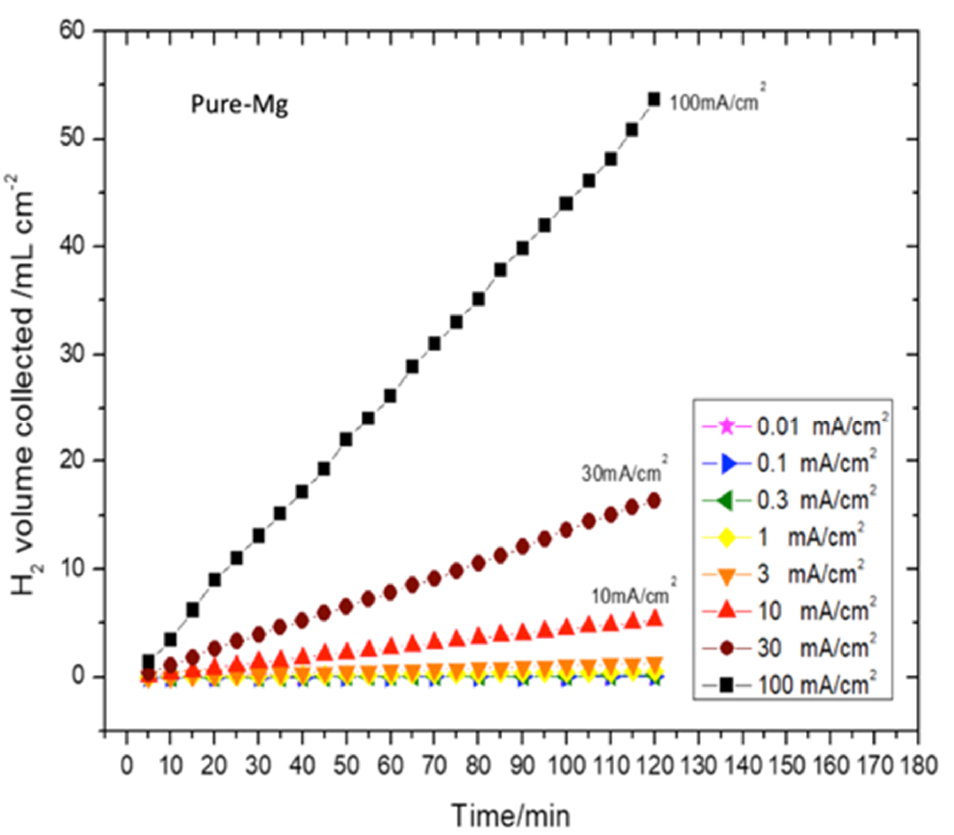
Figure 11. Typical measurements of the anodic hydrogen volume evolved on pure Mg and the Mg alloy WE43 on anodic polarization [92]. The slope of each curve gives the anodic hydrogen evolution rate as plotted in Figure 10.